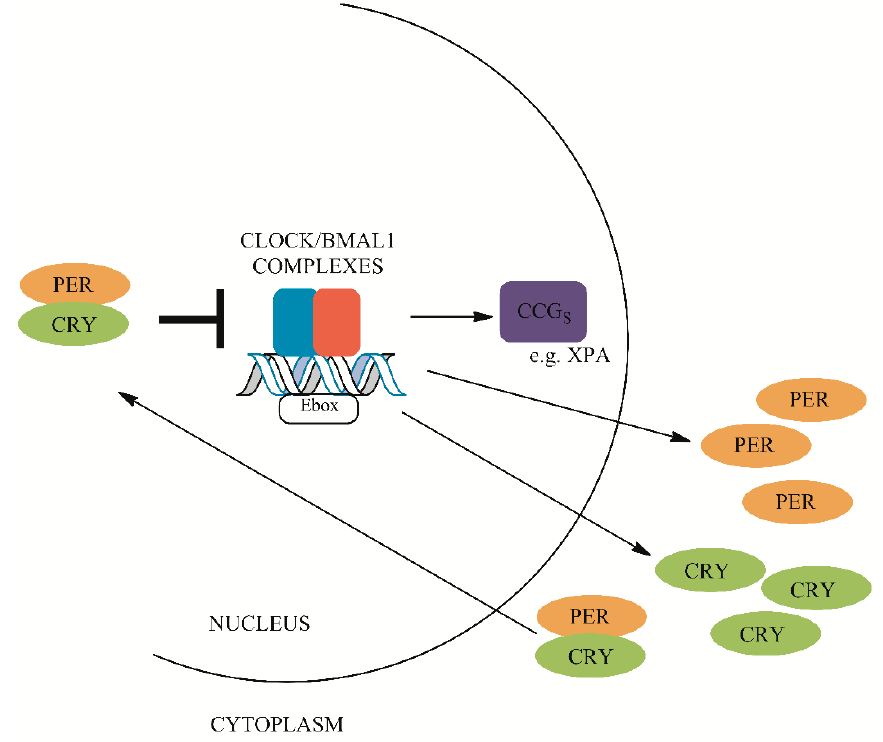
Figure 3. Transcription–translational feedback loop (TTFL) of the circadian clock. Circadian locomotor output cycles protein kaput (CLOCK) and brain and muscle ARNT-like 1 (BMAL1) complexes regulate the expression of period ( PER1 / 2 / 3 ) and cryptochrome ( CRY1 / 2 ) genes. After translation, CRY and PER proteins accumulate in the cytoplasm. This is followed by their heterodimerization and translocation to nucleus and subsequent inhibition of CLOCK–BMAL1-mediated transcription. CLOCK–BMAL1 complexes control expression of other clock-controlled genes (CCGs), such as the XPA gene.